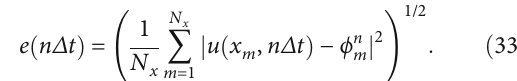
= 0 and (b) ϕ = 0 : 4 with di ff erent ave ave